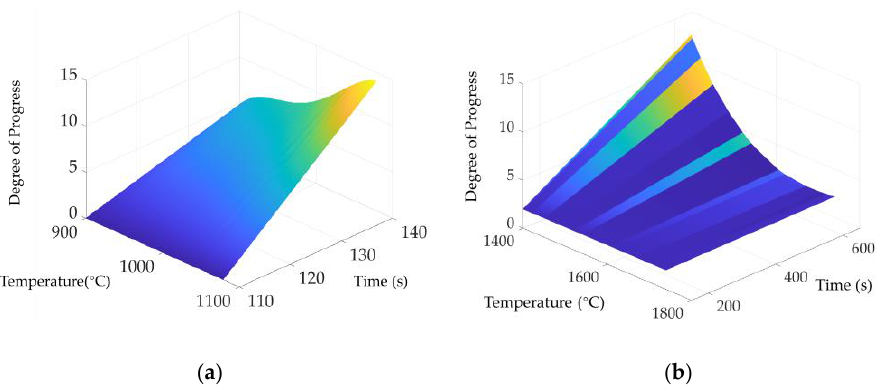
Figure 13. Relationship between crystallization volume ratio, temperature and time during the melting process of mold flux. ( a , b ) are the results corresponding to melting and crystallization, respectively.